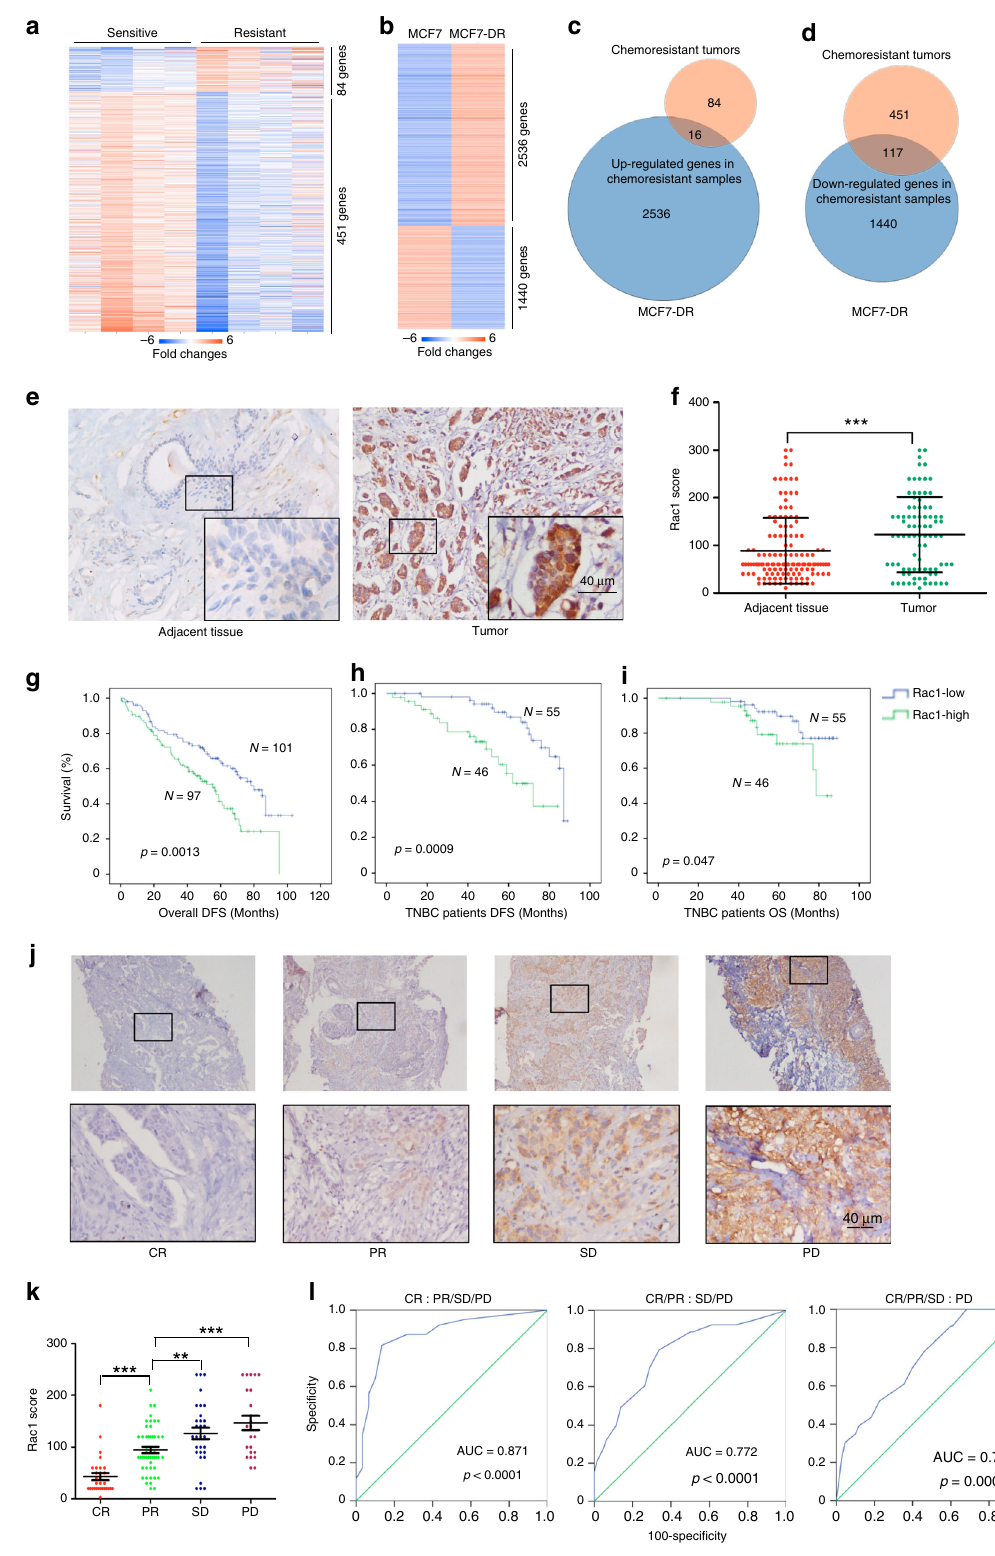
Fig. 2E, F). In addition, overexpression of Rac1 in MDA-MB-436 dramatically increased the resistance of MDA-MB-436 cells to these chemotherapeutic drugs, as shown by the increased cell proliferation, colony formation and reduced apoptosis (Fig. 2d – f, S2G –